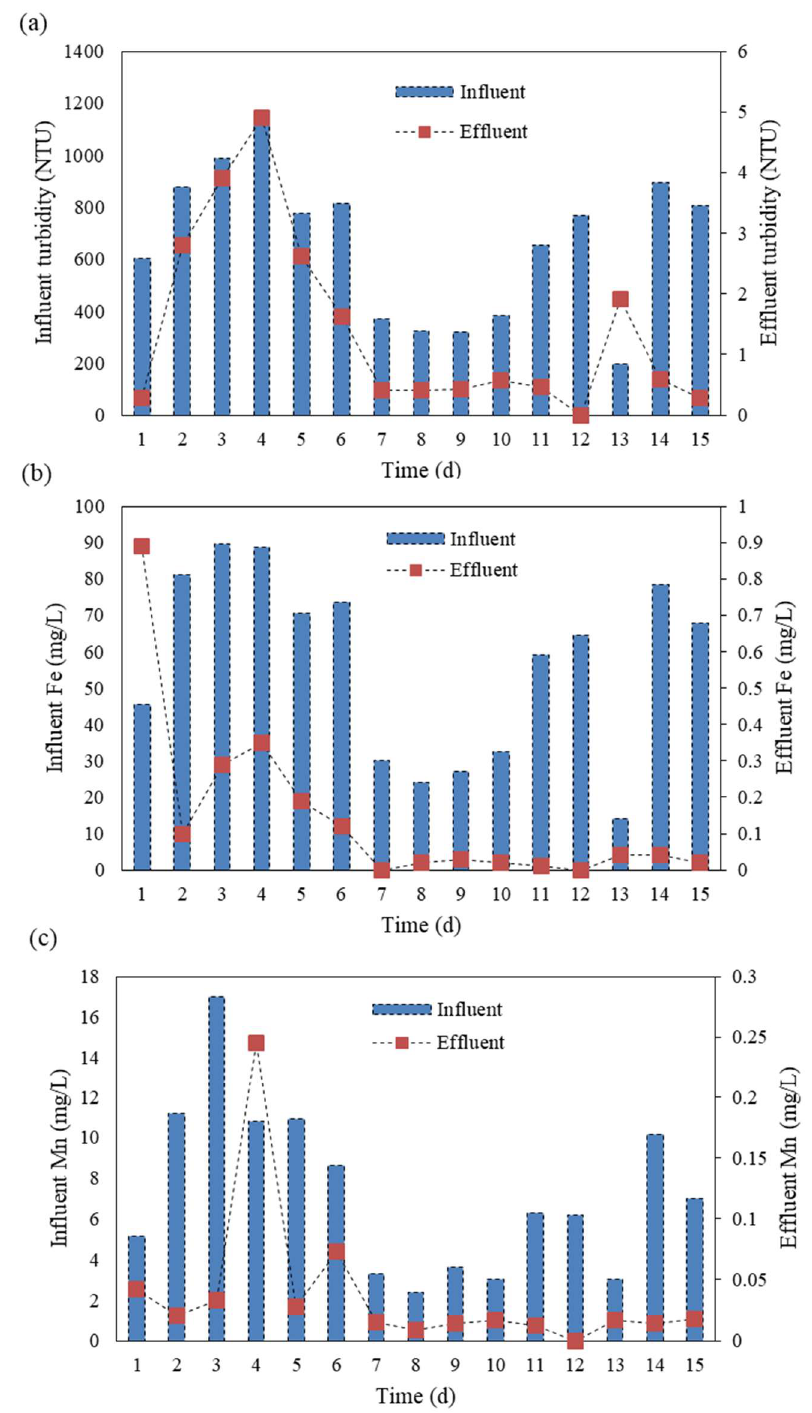
Figure 3. Removal performances of ( a ) turbidity, ( b ) Fe, and ( c ) Mn by using continuous ceramic filtration experiments.